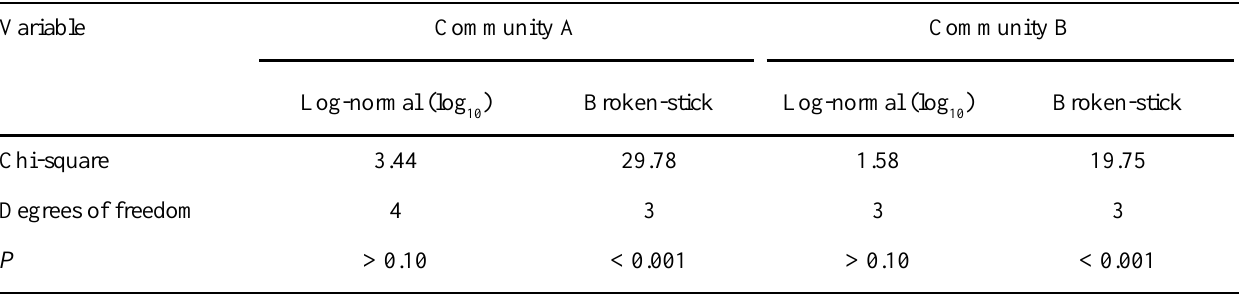
Table 6. Comparison of log-normal and broken-stick species abundance models using chi-square goodness- of-fit